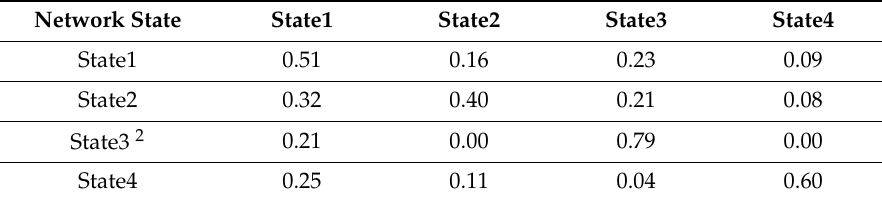
Table 1. Transition probabilities between states. 1